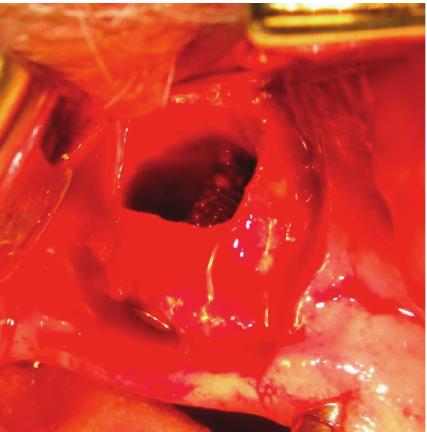
Figure 4: Surgical technique. An osteotomy is performed, and the bony window is temporarily removed. The installed implant is here seen elevating the sinus membrane, and, after blood has filled the created compartment around the implant, the bony window is thereafter